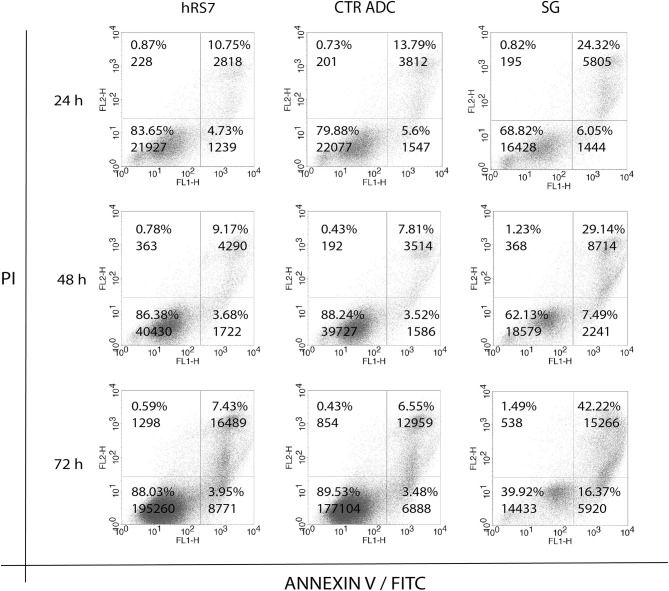
Time dependent cytotoxicity of hRS7, control ADC and SG after 24, 48, and 72 h exposure. Down right and up left quadrants show single positive events for FL1-H (ANNEXIN V-FITC, apoptosis) and FL2-H (Propidium Iodide, necrosis), respectively. Up right quadrant shows double positive events for FL1-H and FL2-H, respectively. Double positive events stand for tardive apoptosis. Maximal cytotoxicity of SG was demonstrated after 72 h exposure.